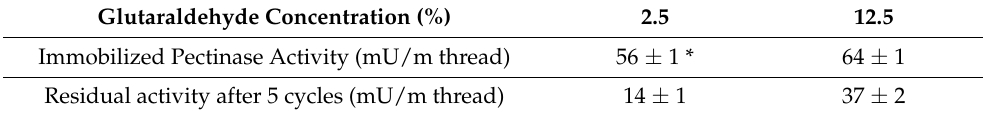
Table 3. The effect of glutaraldehyde concentration on pectinase immobilization. Glutaraldehyde Concentration (%) 2.5 12.5 Immobilized Pectinase Activity (mU/m thread) 56 ± 1 * 64 ± 1 Residual activity after 5 cycles (mU/m thread) 14 ± 1 37 ±